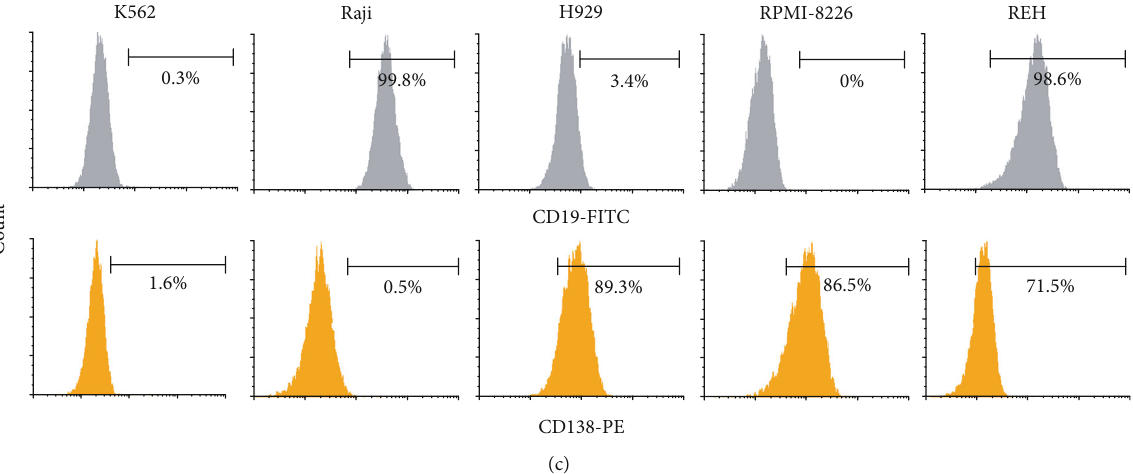
Figure 2: Generation of CD19-NK-92 and CD138-NK-92 cells and analysis of surface antigens in target cancer cells. (a) NK-92 cells were subjected to multiple rounds of lentiviral transduction of anti-CD19-CAR or anti-CD138-CAR and sequential FACS enrichment using anti-F(ab ′ )2 antibody to generate highly expressed, stable CD19-NK-92 and CD138-NK-92 cells. (b) CAR expression in enriched CD19-NK-92 ( left ) and CD138-NK-92 ( right ) cells, as evaluated by fl ow cytometry based on its binding activity to His tag-rhCD19 or His tag-rhCD138. (c) Flow cytometric analysis of surface CD19 and CD138 expression in human CML-derived K562, human ALL-derived REH, human BL-derived Raji, and human MM-derived H929 and RPMI-8226